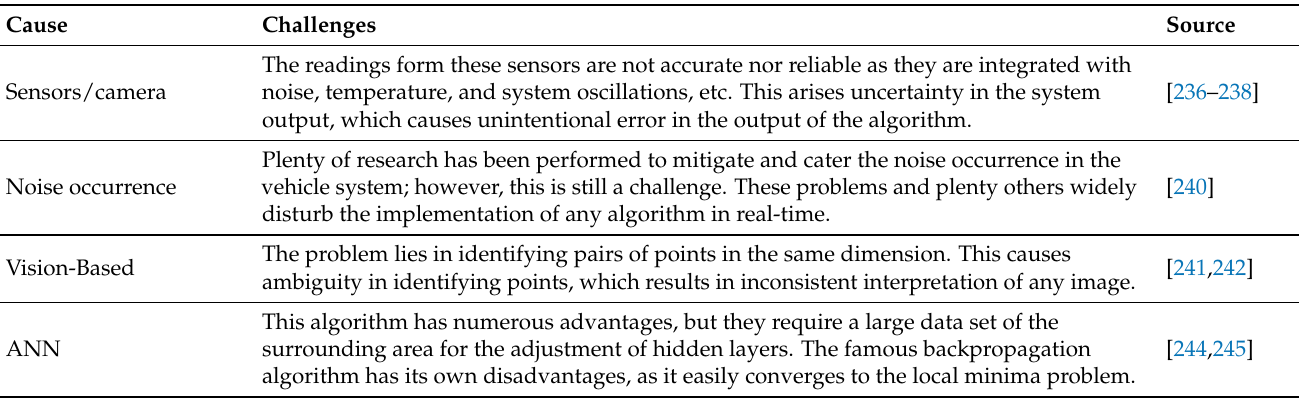
Table 7. Challenges involved in Path